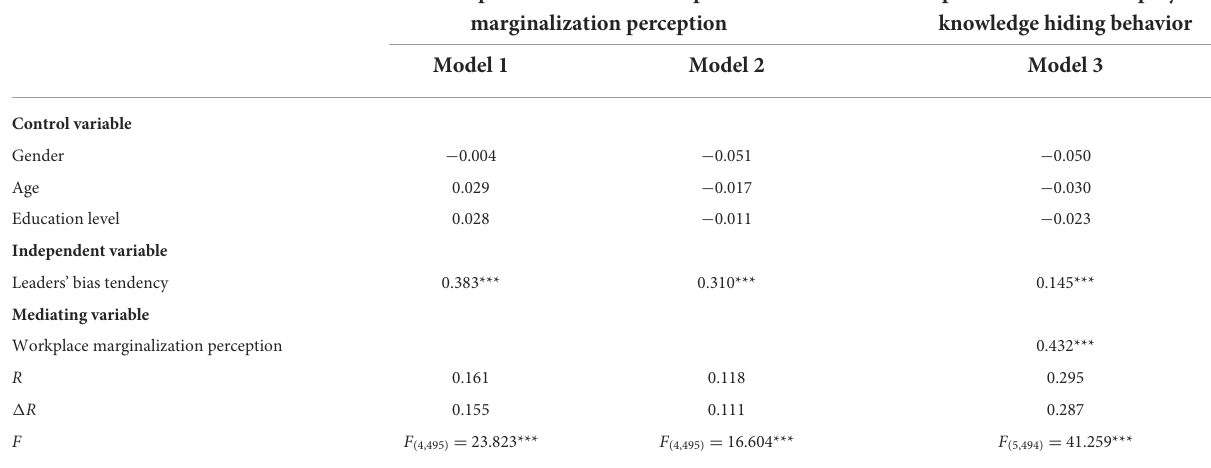
TABLE 4 Hypothesis